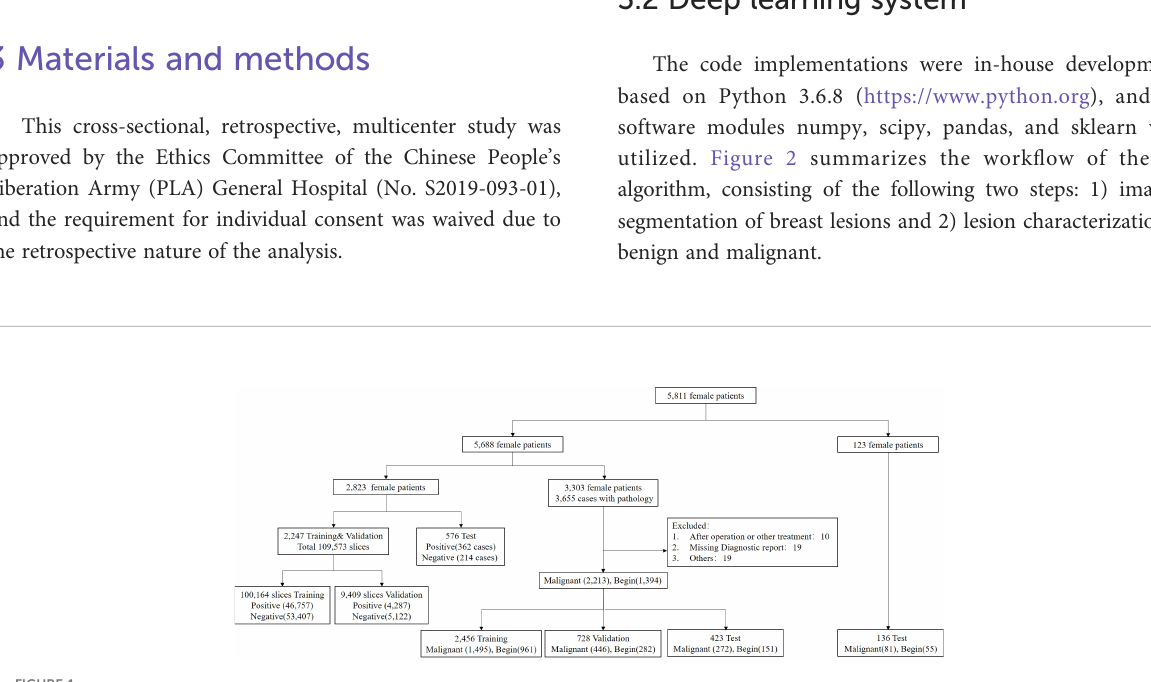
FIGURE 1 Flowchart of the fi nal analysis cohort. A total of 5,811 patients were included in this study. A total of 5,688 patients within our institution were used for the segmentation and characterization model training, validation, and testing, and 123 patients from another institution were used for external testing of the proposed characterization